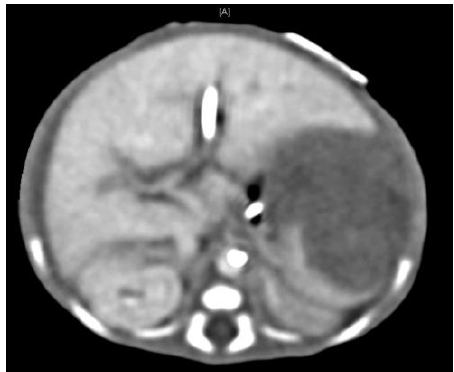
Figure 1: Computerized tomographic scan with IV con- trast of abdomen. As the patient was hemodynamically stable, surgical exploration was not done. The patient was given multiple transfusions of fresh frozen